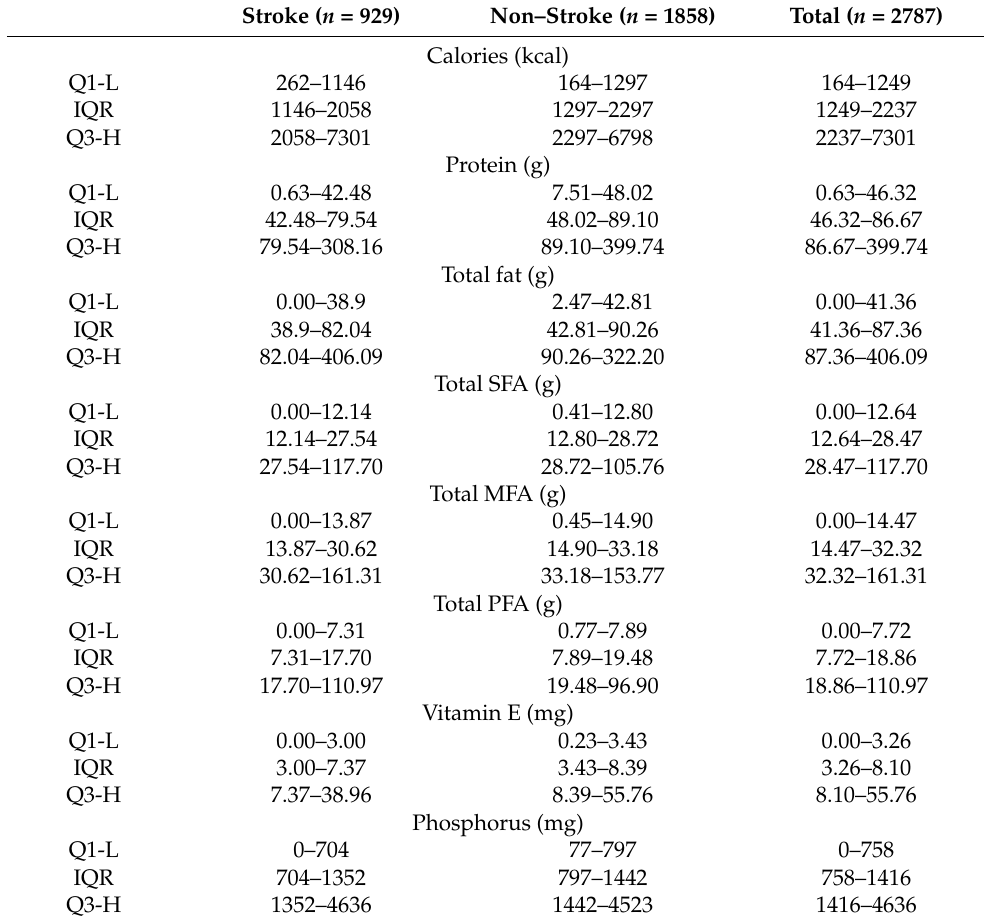
Table 2. Quartiles of dietary consumption with and without